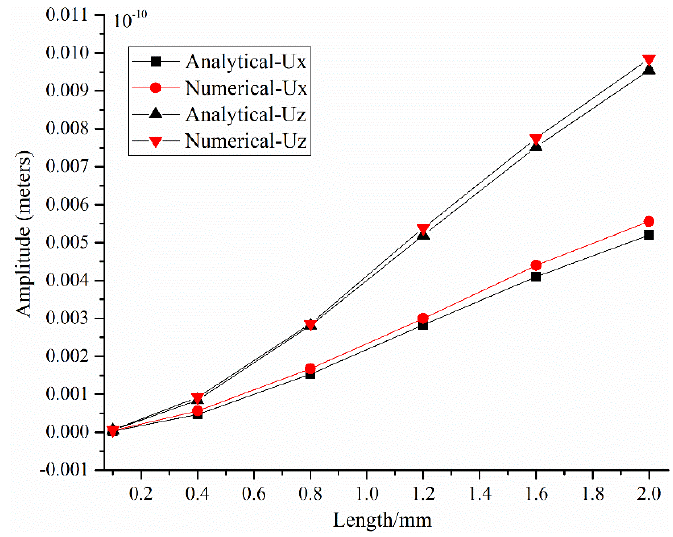
Figure 6. Comparison diagram of theoretical and simulation amplitudes.